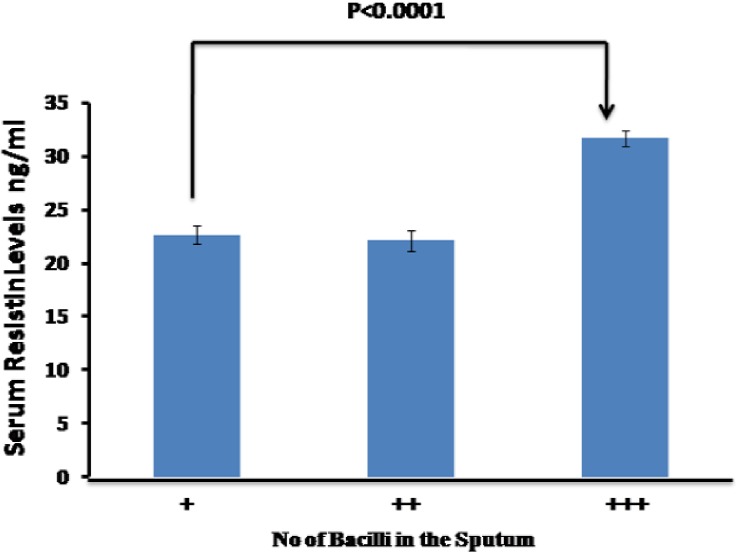
Mean serum resistin levels increases with bacterial load especially in the patients with chronic infection.Analysis of variance shows significant association between resistin and bacterial load P ˂0.05.